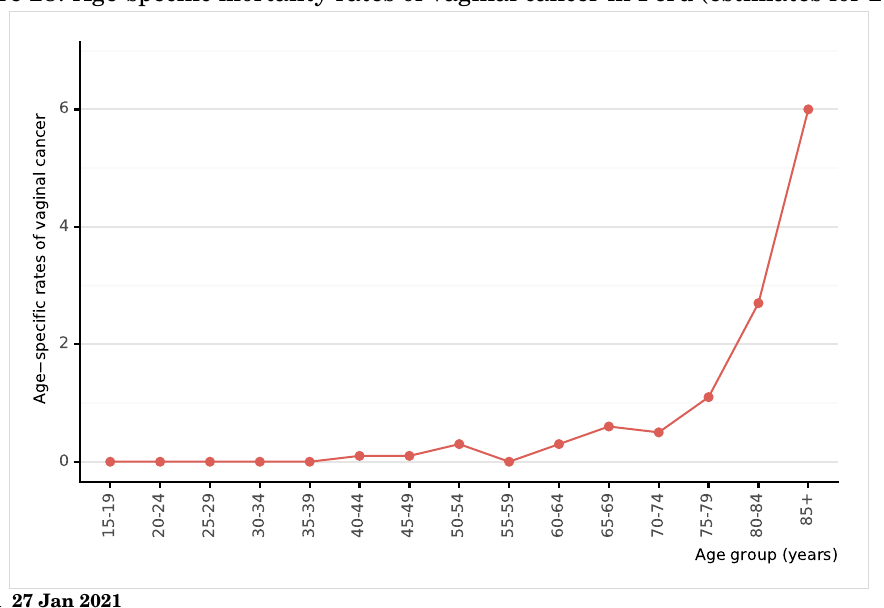
Figure 28: Age-specific mortality rates of vaginal cancer in Peru (estimates for 2020)